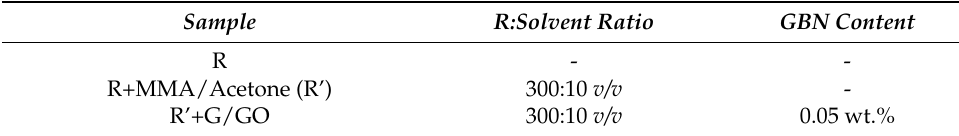
Table 3. Composition of GBN-based composite samples.